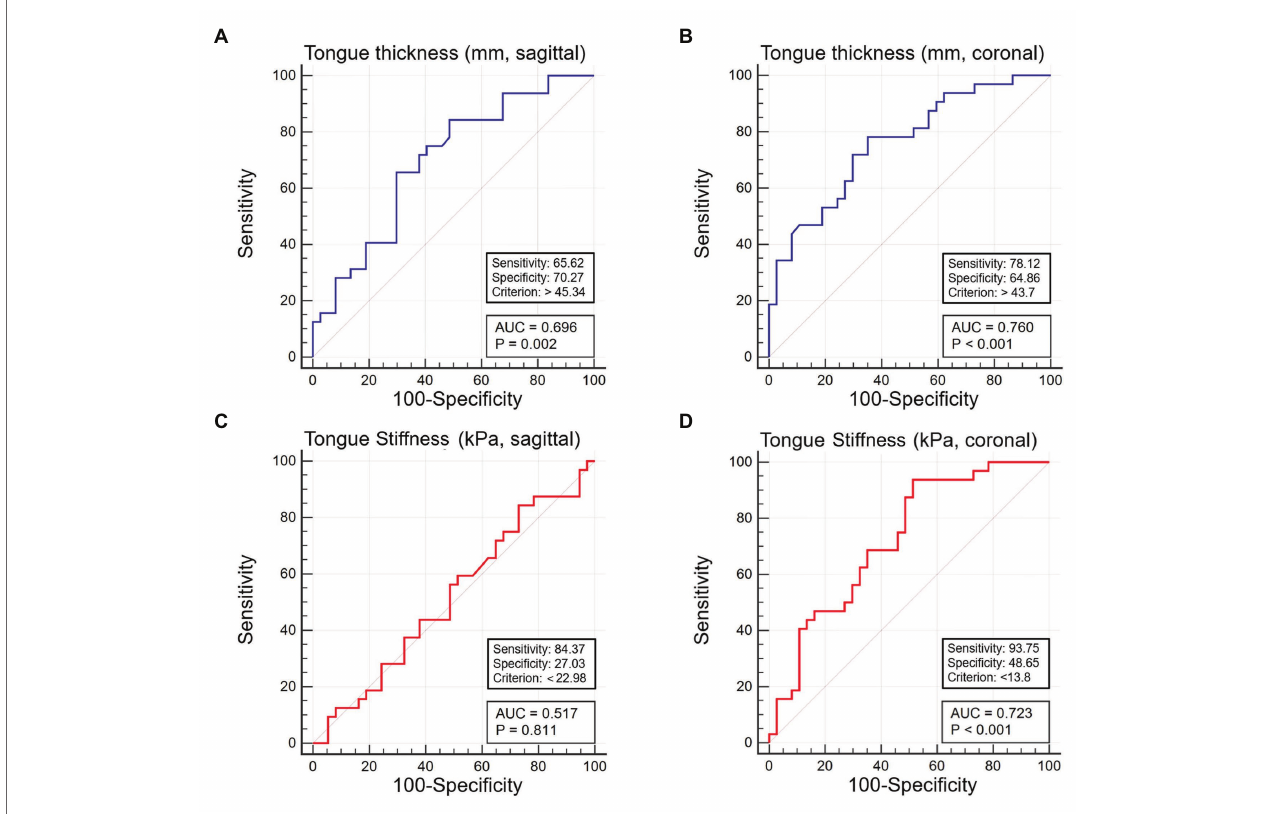
FIGURE 5 | Receiver operating characteristic curve analysis for ultrasound measurements of tongue thickness in the sagittal (A) and coronal (B) views, and tongue elasticity in the sagittal (C) and coronal (D) views for discriminating participants with and without obstructive sleep apnea.